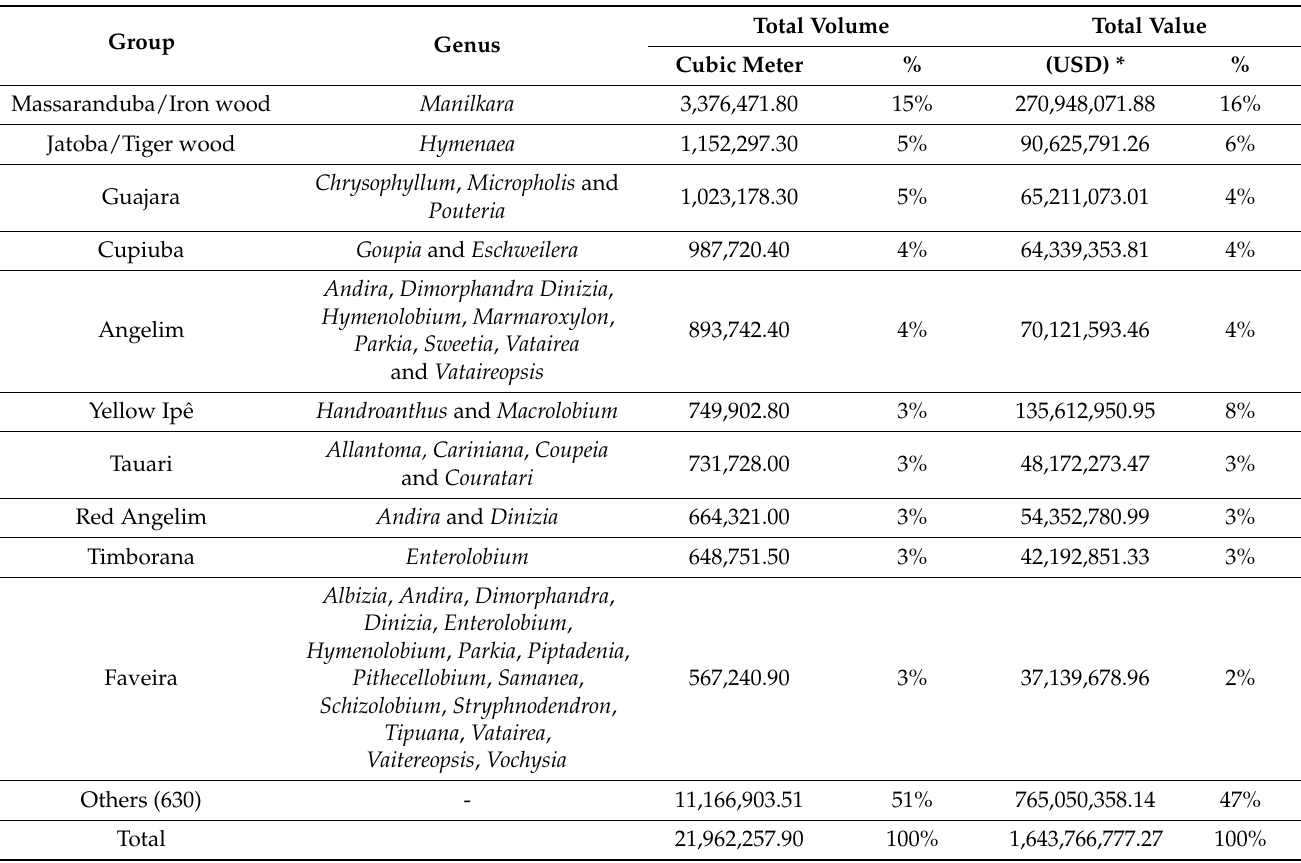
Table 3. List of the most marketed species in the state between 2009 and